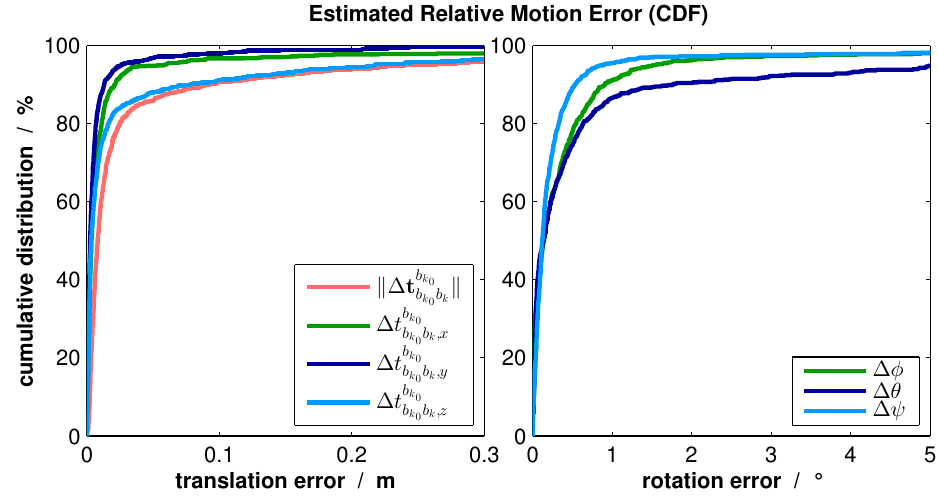
Figure 12. Ego-motion estimation errors occurring in a real indoor flight (CDF).